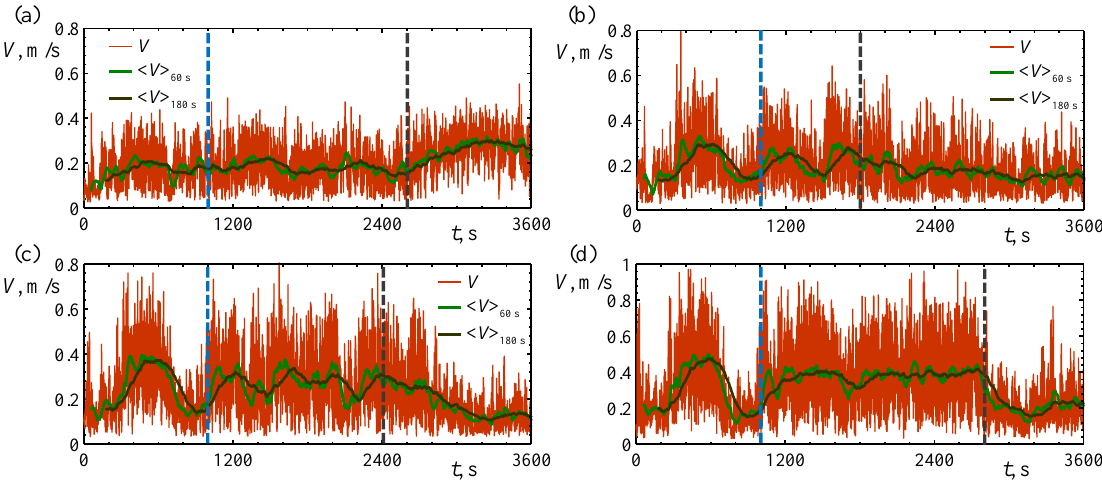
Figure 4. Evolution of velocity at the inspected points: ( a ) z = 0.1 m, ( b ) z = 0.6 m, ( c ) z = 1.1 m, ( d ) z = 1.7 m.